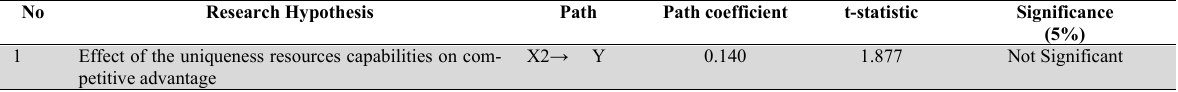
Effect of Uniqueness of resource capability on the competitive advantage of MSMEs in Jambi